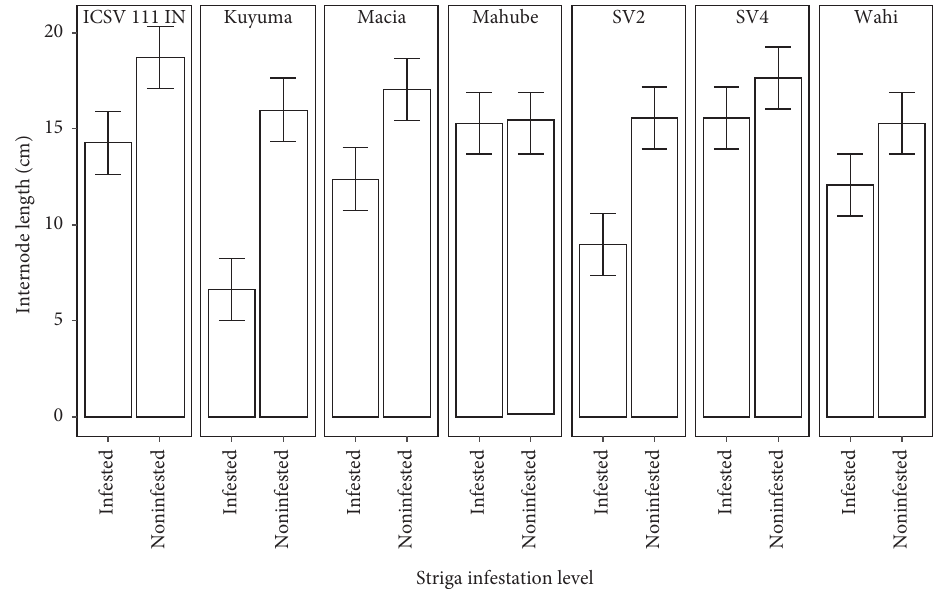
Figure 2: Effect of S. asiatica infestation on sorghum genotypes internode length recorded under pot experiment. Error bars indicate LSD at p < 0 . 05. Table 5: Response of sorghum genotypes to S. asiatica infestation under pot environments. Internode length Days to Source Height (cm) (cm)